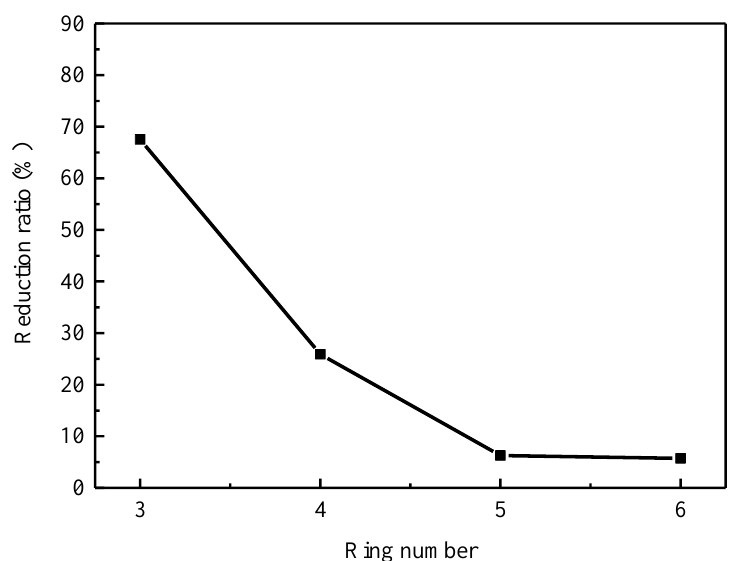
Figure 6. Soluble PAHs content of toluene in raw CTP and the catalytic air-oxidized CTP. Air-oxi- dized CTP.